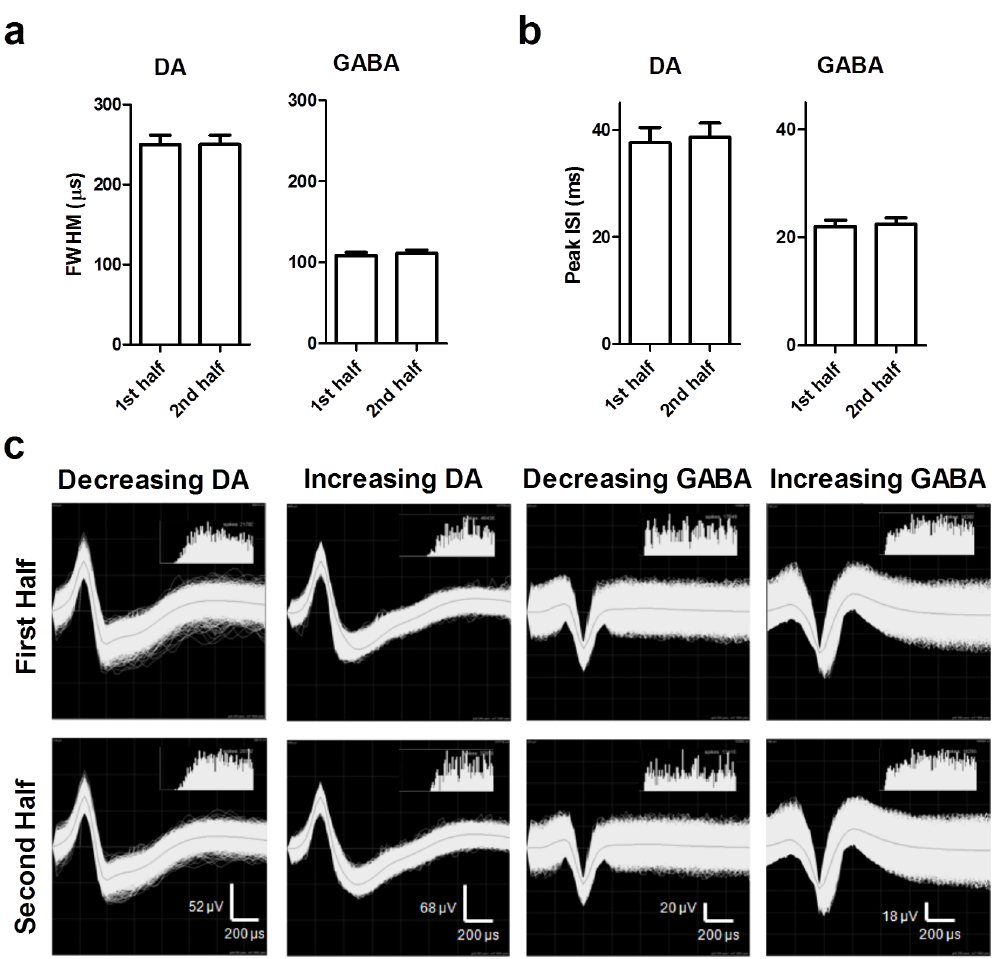
Figure 7. Modulation is not due to changes in neuron isolation. To test whether changes in neuronal isolation could account for the modulation observed in single unit activity, waveform characteristics were calculated for all modulated neurons for each half of the recording session. Neither FWHM ( a ) nor the peak of the inter-spike interval (ISI; b ) changed during the two-hour recording sessions (paired t -tests, p . 0.05). ( c ) Sample traces from the first and second half of the session for modulated neurons. The range of ISI values shown is 0–30